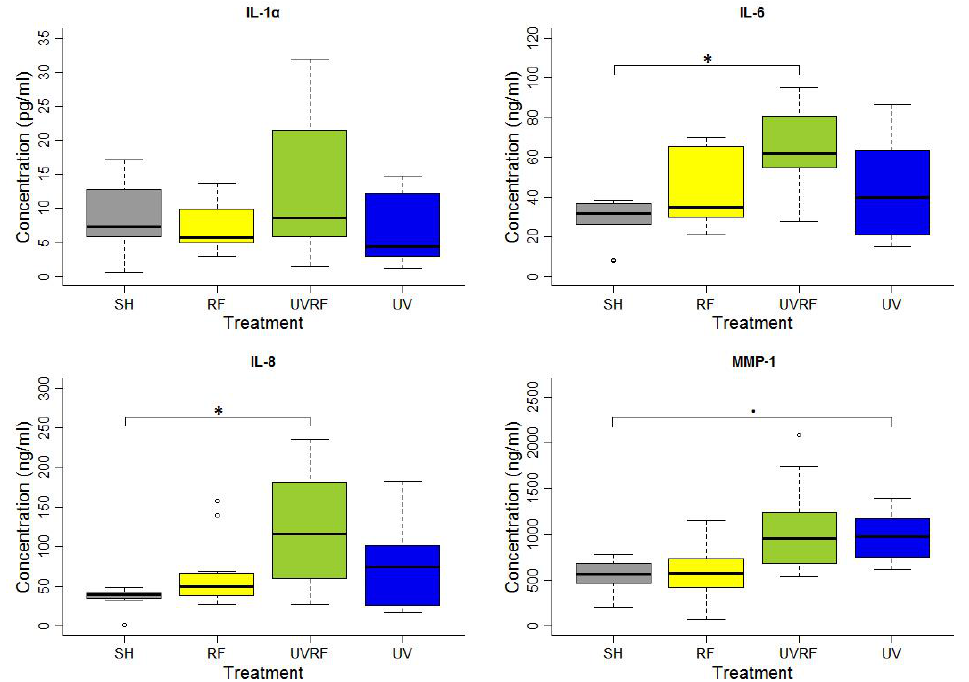
Figure 1. Results of the experiments performed under the additive effect protocol where the skin tissues were exposed first to 2 SED UV and then to 24 h 2422 MHz intermittent 20 min on/off Wi-Fi exposure with 4 W/kg SAR. The data represent three independent experiments. The boxplot shows the median (thick line) and the lower and upper quartiles (the bottom and top lines of the box), and the whiskers show the minimum and maximum values; • = 0.05, * p < 0.05, ◦ :